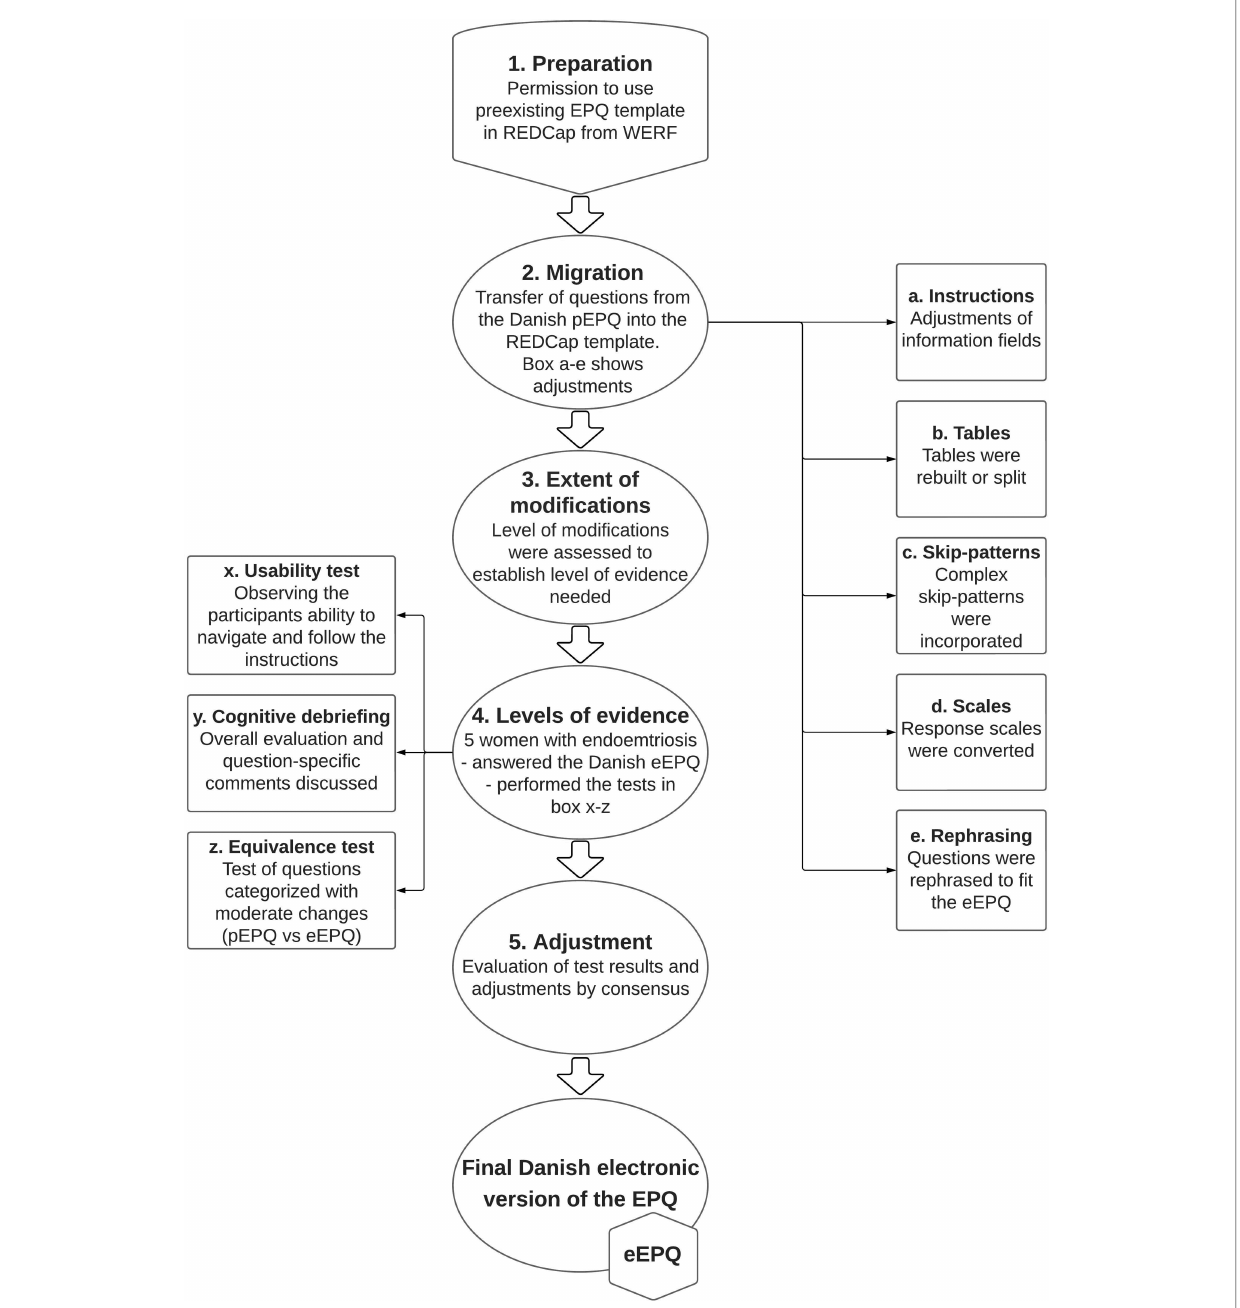
correlation between the ratio and ordinal scale data from the two modes of